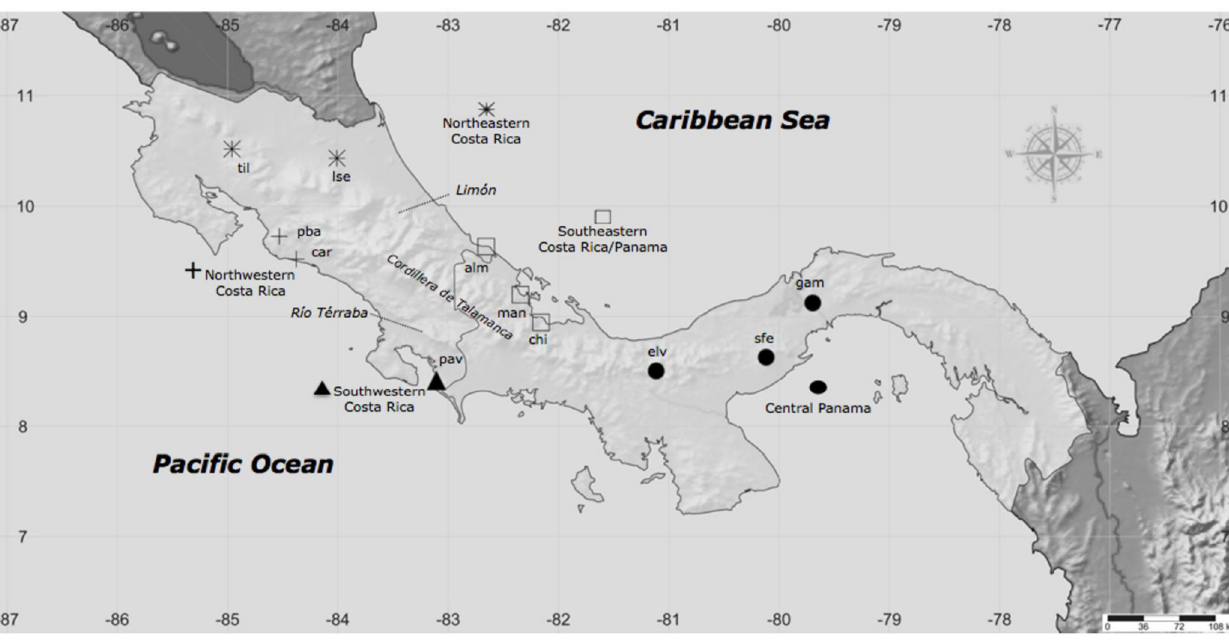
Frontiers in Ecology and Evolution |